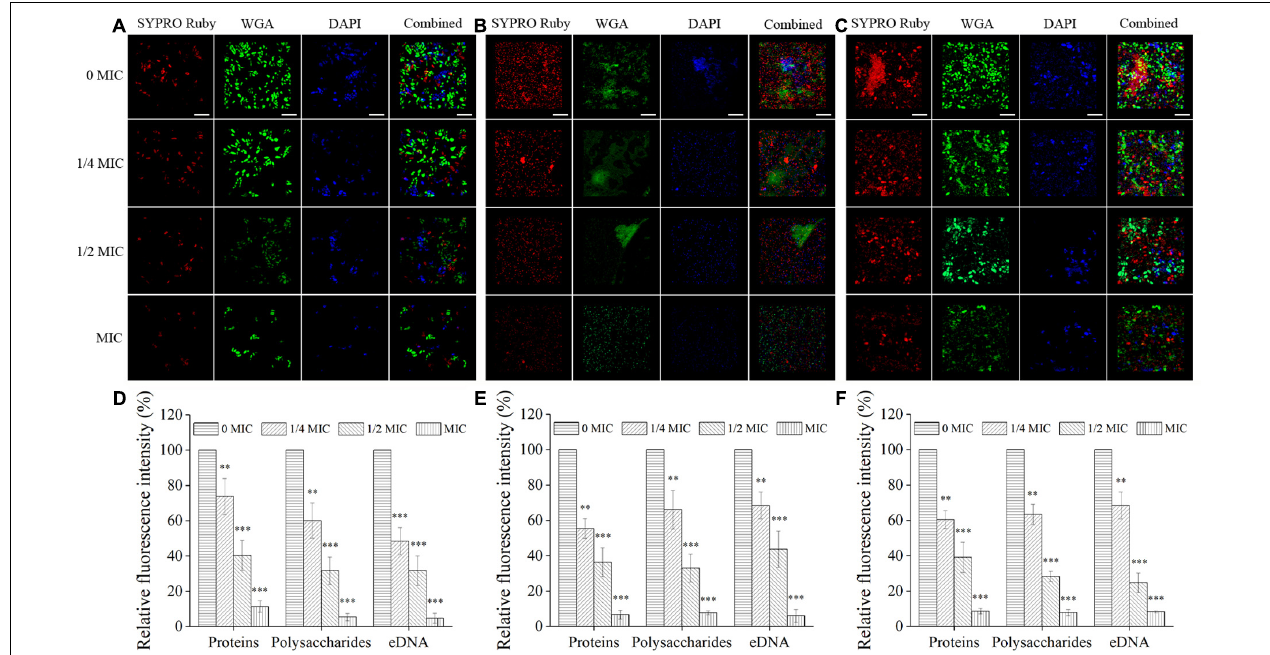
FIGURE 5 | The effects of luteolin on the levels of the matrix component inside biofilms formed by C. albicans SC5314 (A) , E. faecalis 20033 (B) , and dual species (C) by confocal laser scanning microscope (CLSM). Extracellular proteins, polysaccharides, and eDNA were labeled with SYPRO Ruby, WGA, and 4 (cid:48) ,6-diamidino-2-phenylindole (DAPI), respectively. Scale bars represent 20 µ m. The relative fluorescence intensity of matrix components within biofilms by C. albicans SC5314 (D) , E. faecalis 20033 (E) , and dual species (F) in each exposure group was calculated and plotted against that in the untreated group using Image-Pro Plus 6.0 software, respectively. Scale bars represent the standard deviation (SD) ( n = 3). ∗∗ p < 0.01; ∗∗∗ p <